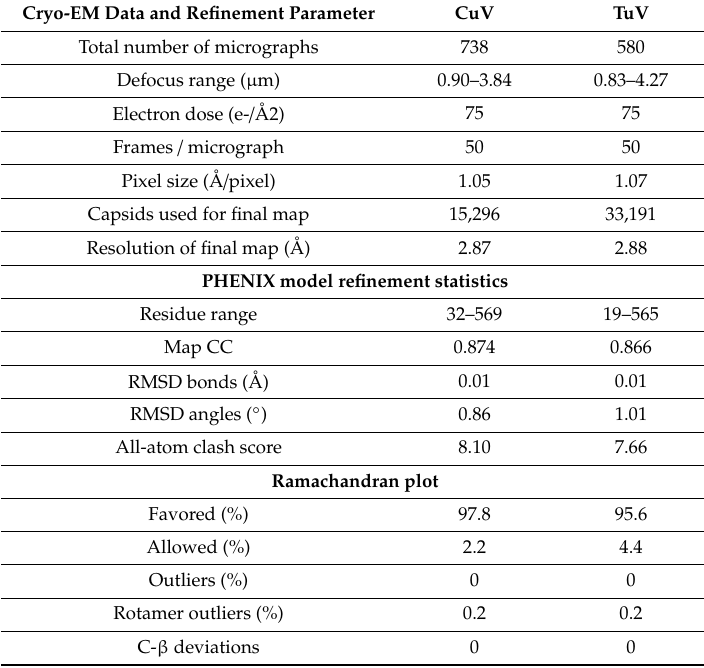
Table 1. Summary of data collection, image-processing, and refinement statistics for CuV and